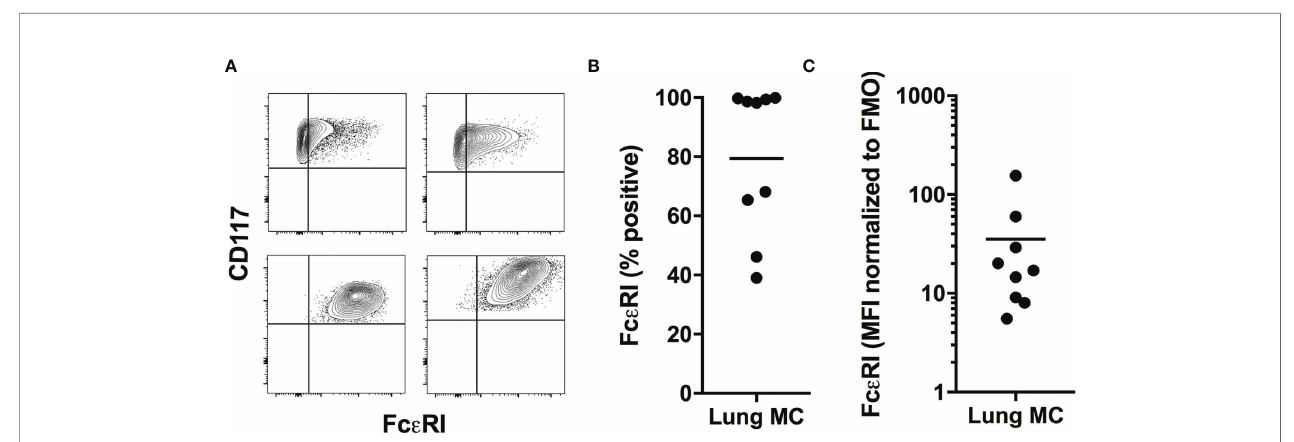
FIGURE 3 | Fc e RI expression on HLMCs. Examples of CD117/Fc e RI expression on HLMCs gated as CD45 + CD14 low CD117 high cells from four donors (A) . Quanti fi cation of the percent positive for Fc e RI (B) and the MFI of Fc e RI normalized to that of the matched FMO control (C) . n =